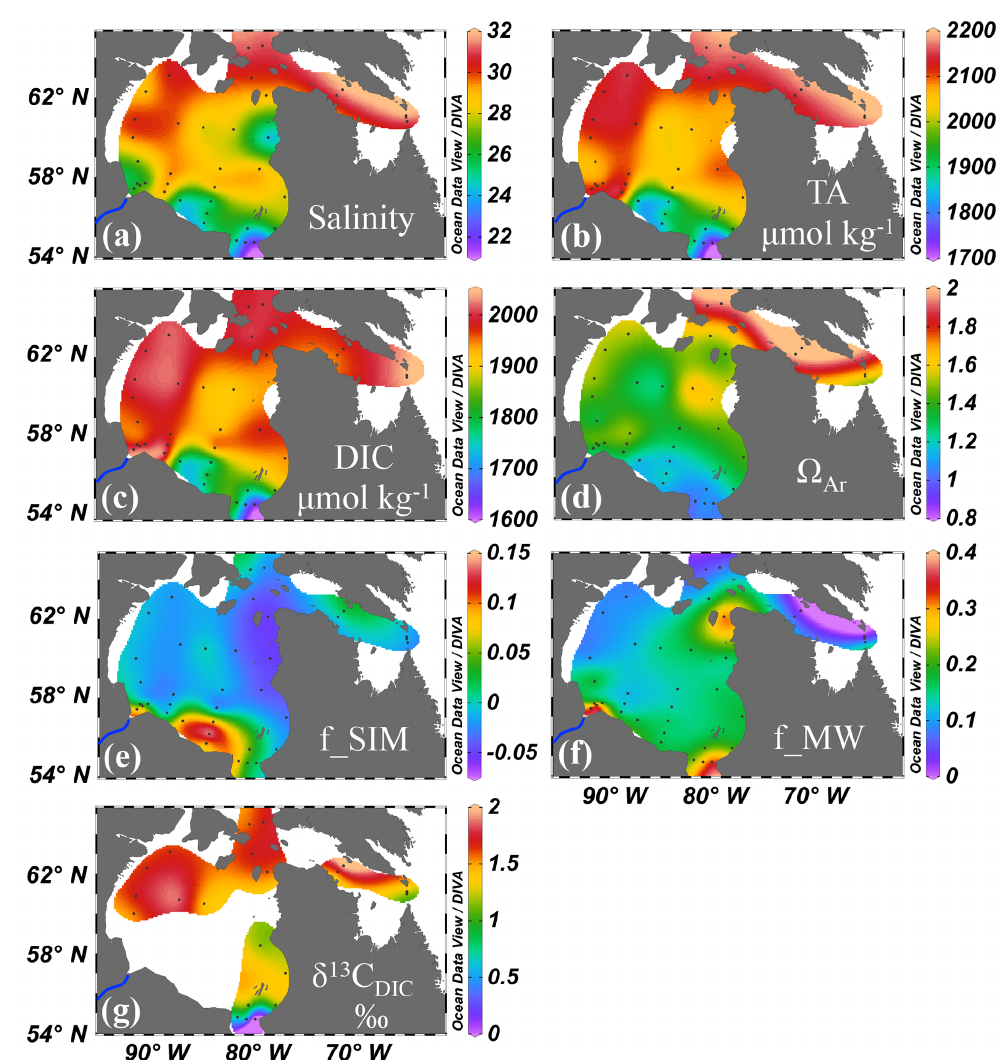
Figure 2. Surface distributions of salinity (a) , TA (b) , DIC (c) , aragonite saturation state ( (cid:127) Ar ) (d) , sea-ice-melt fraction ( f _SIM) (e) , meteoric water fraction ( f _MW) (f) , and δ 13 C DIC ( g , samples only collected during first half of the cruise). Nelson River is shown as a blue line. Note that (cid:127) Ar (d) is above 1 at all